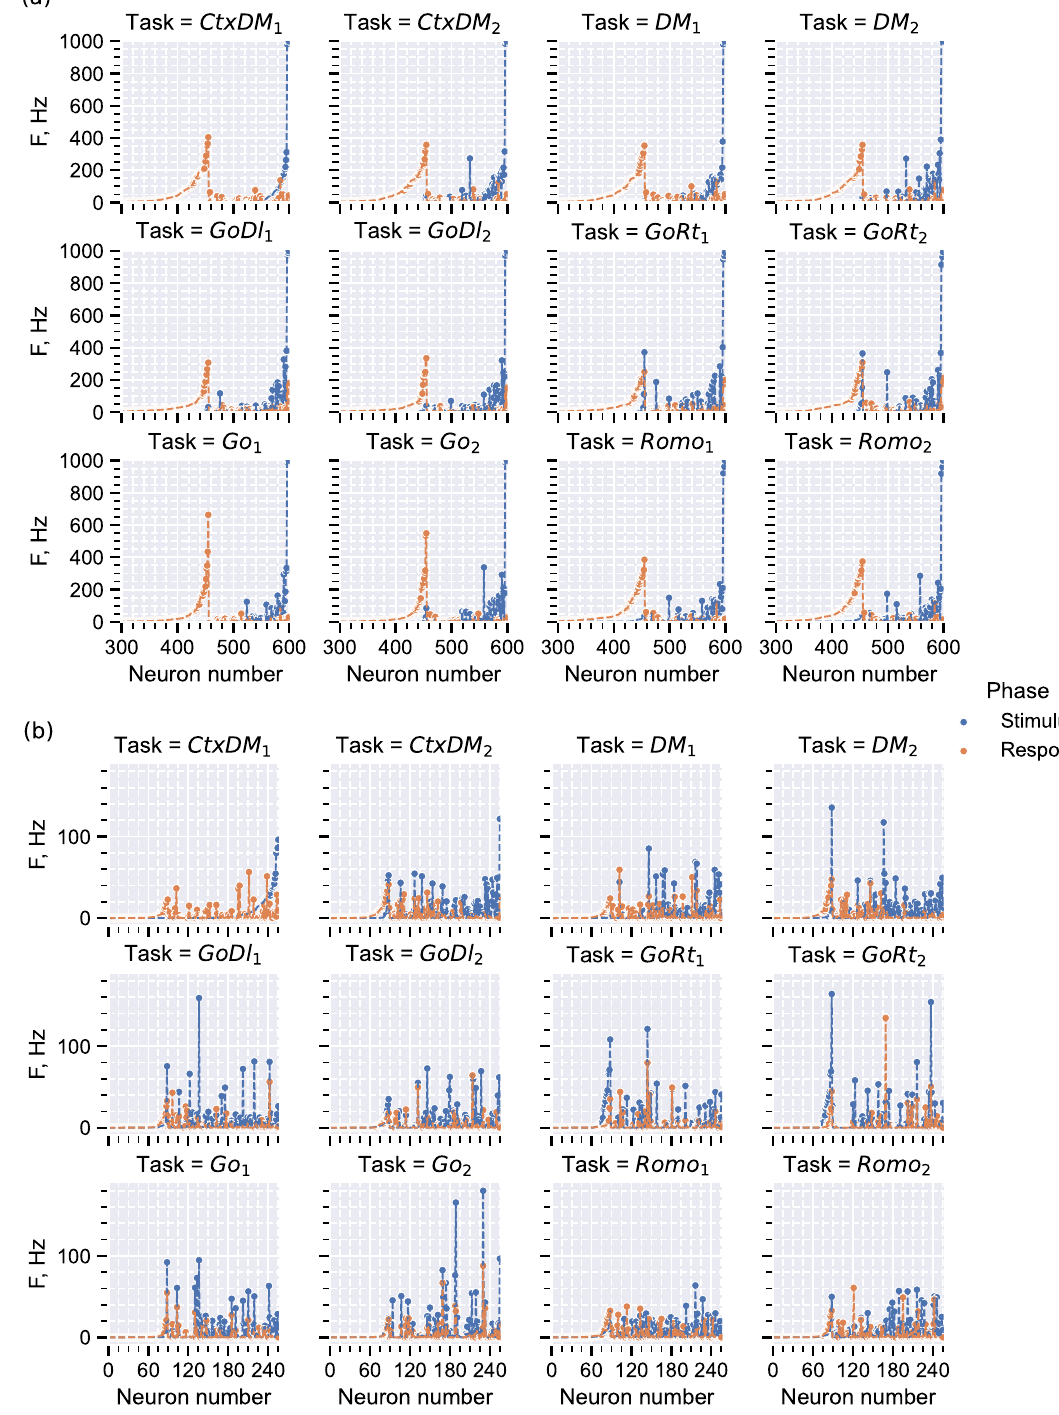
Figure 7. Neuronal firing rate distributions when performing different tasks during the stimulus and response phases. ( a ) Network of 600 neurons trained with the mean-squared loss function (inactive neurons not shown). ( b ) Network of 256 neurons trained with the regularized loss function. The values are obtained after averaging over 100 trials for each task and are sorted in ascending order of the rates during the stimulus phase of the first CtxDM 1